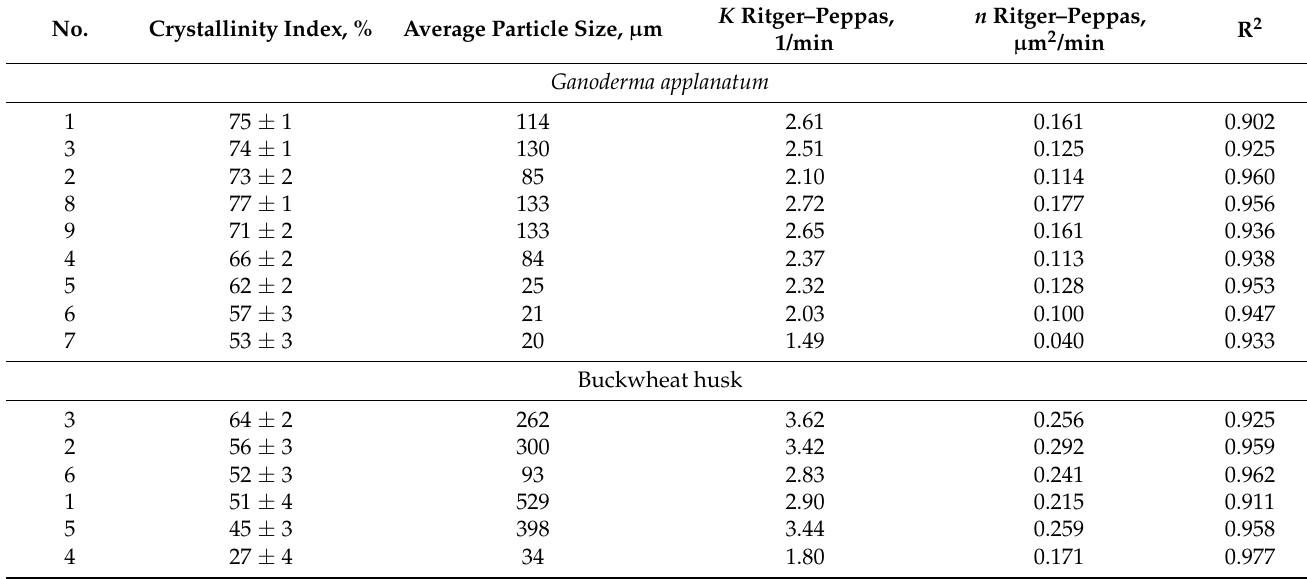
Table 4. The kinetic constant and diffusion exponent according to the Ritger–Peppas model as functions of particle size and crystallinity